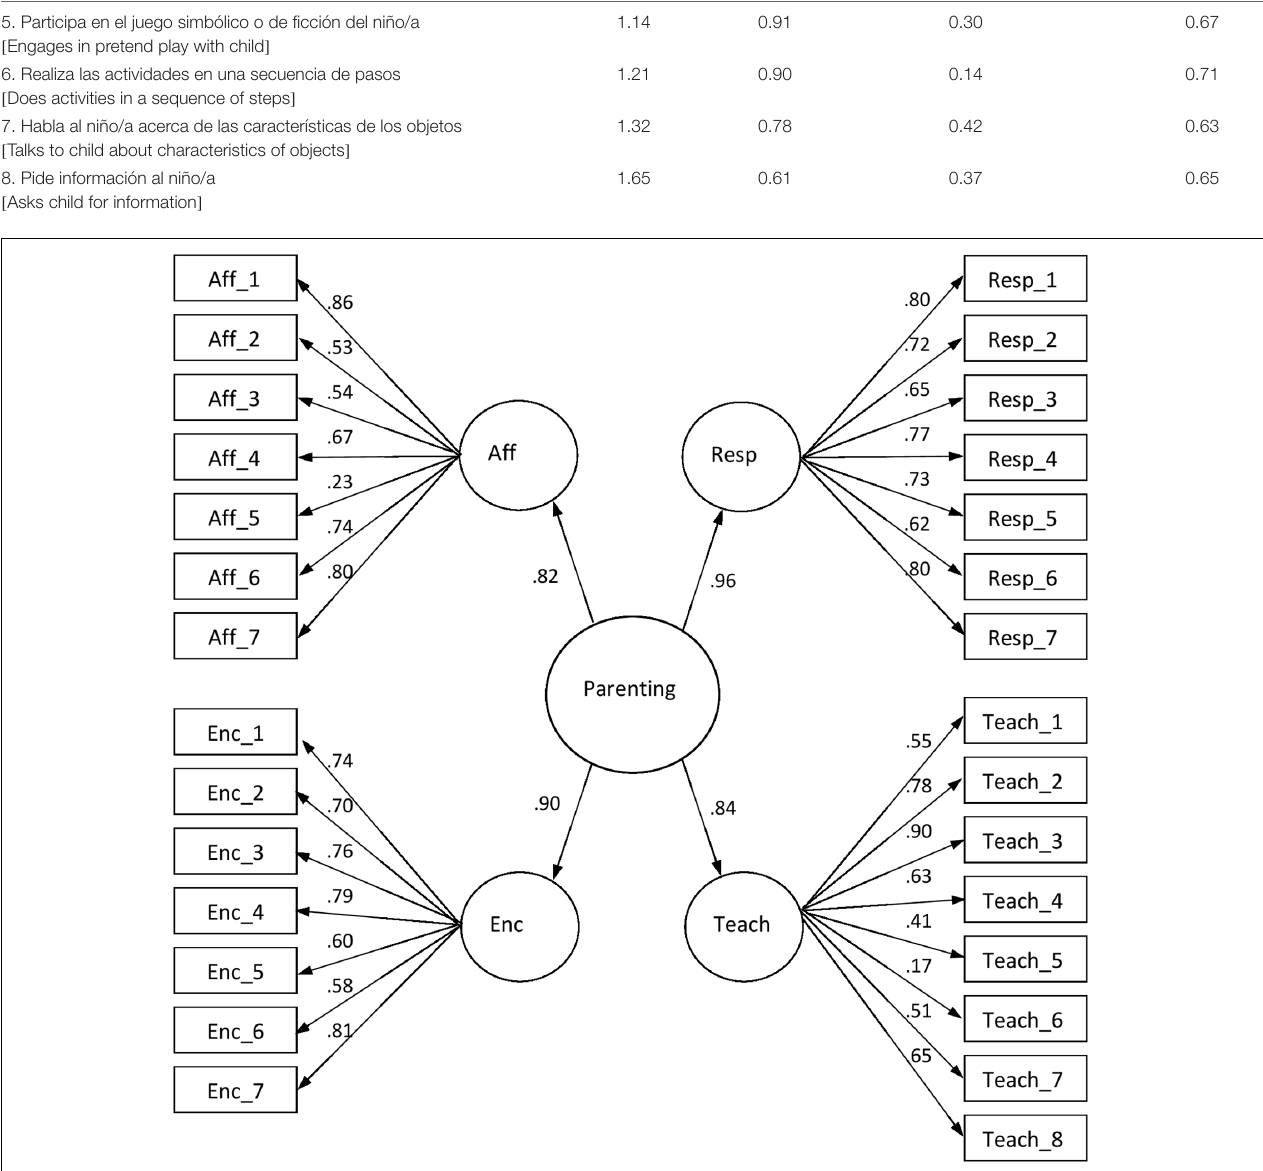
FIGURE 1 | Path diagram of the confirmatory factor analysis. Aff, Affection domain; Resp, Responsiveness domain; Enc, Encouragement domain; Teach, Teaching domain. Affl indicates Item 1 in the affection domain; this shorthand is used throughout. Error terms are omitted.